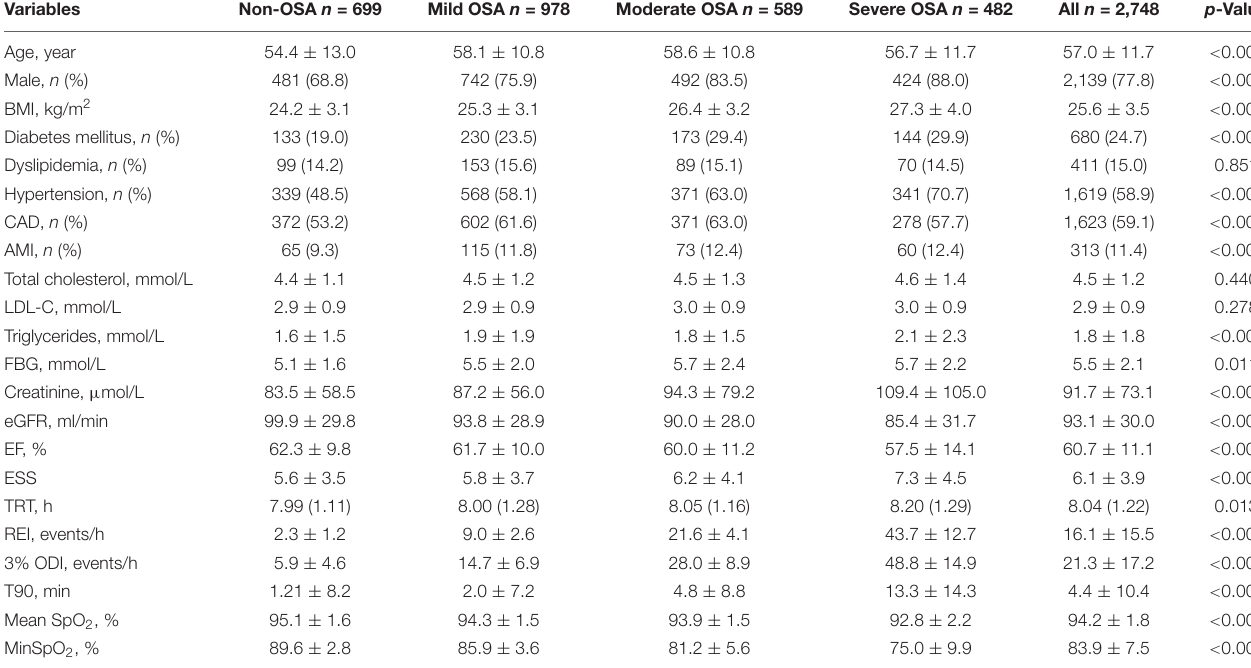
TABLE 1 | Baseline characteristics.